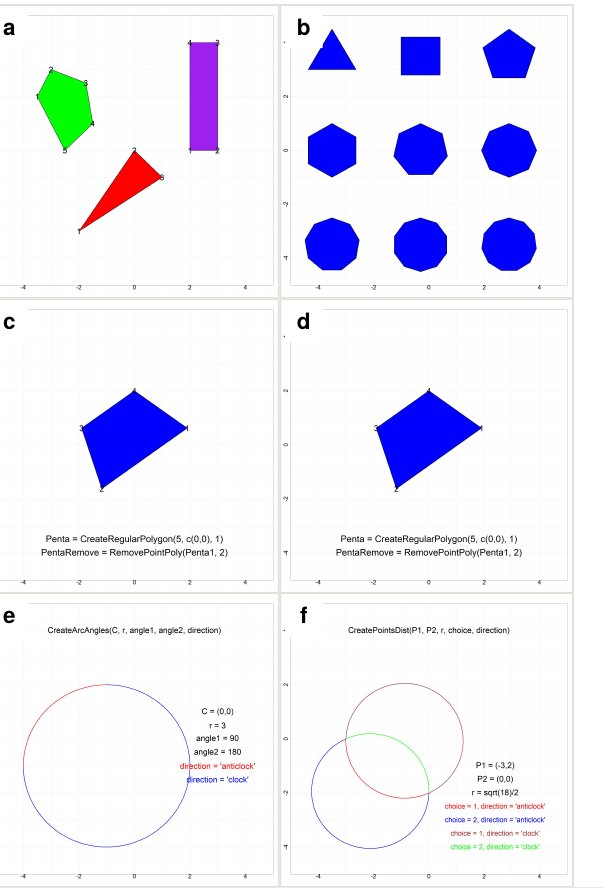
Table 3 clari fi es the structure of the outputs produced by each of the functions and the information which they provide about the geometric object that they represent.